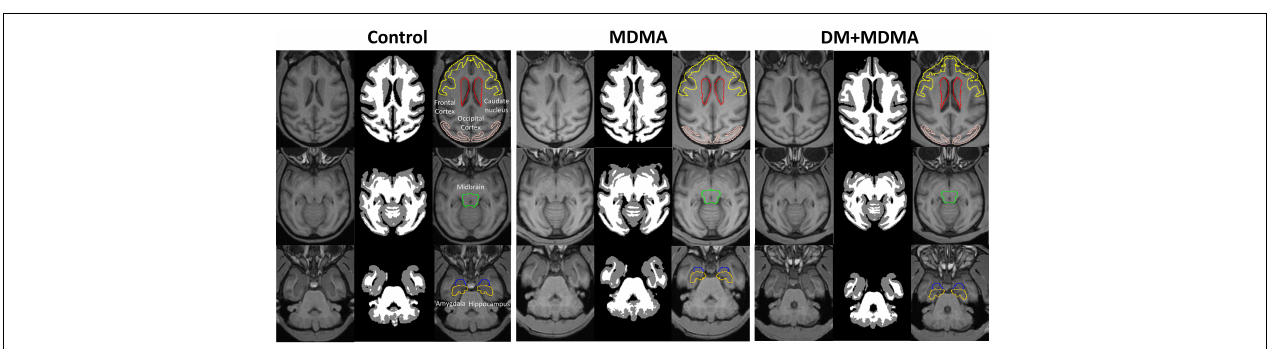
FIGURE 5 | Recovery rate of SERT availability in various brain regions in the control, MDMA, and DM + MDMA groups at 60 and 66 months. Data is presented as mean ± SEM; ∗ p < 0.05, ∗∗ p < 0.01, ∗∗∗ p < 0.005 compared to the control group; # p < 0.05 compared to the MDMA group. ap < 0.01 when compared to DM+MDMA at 60 months.